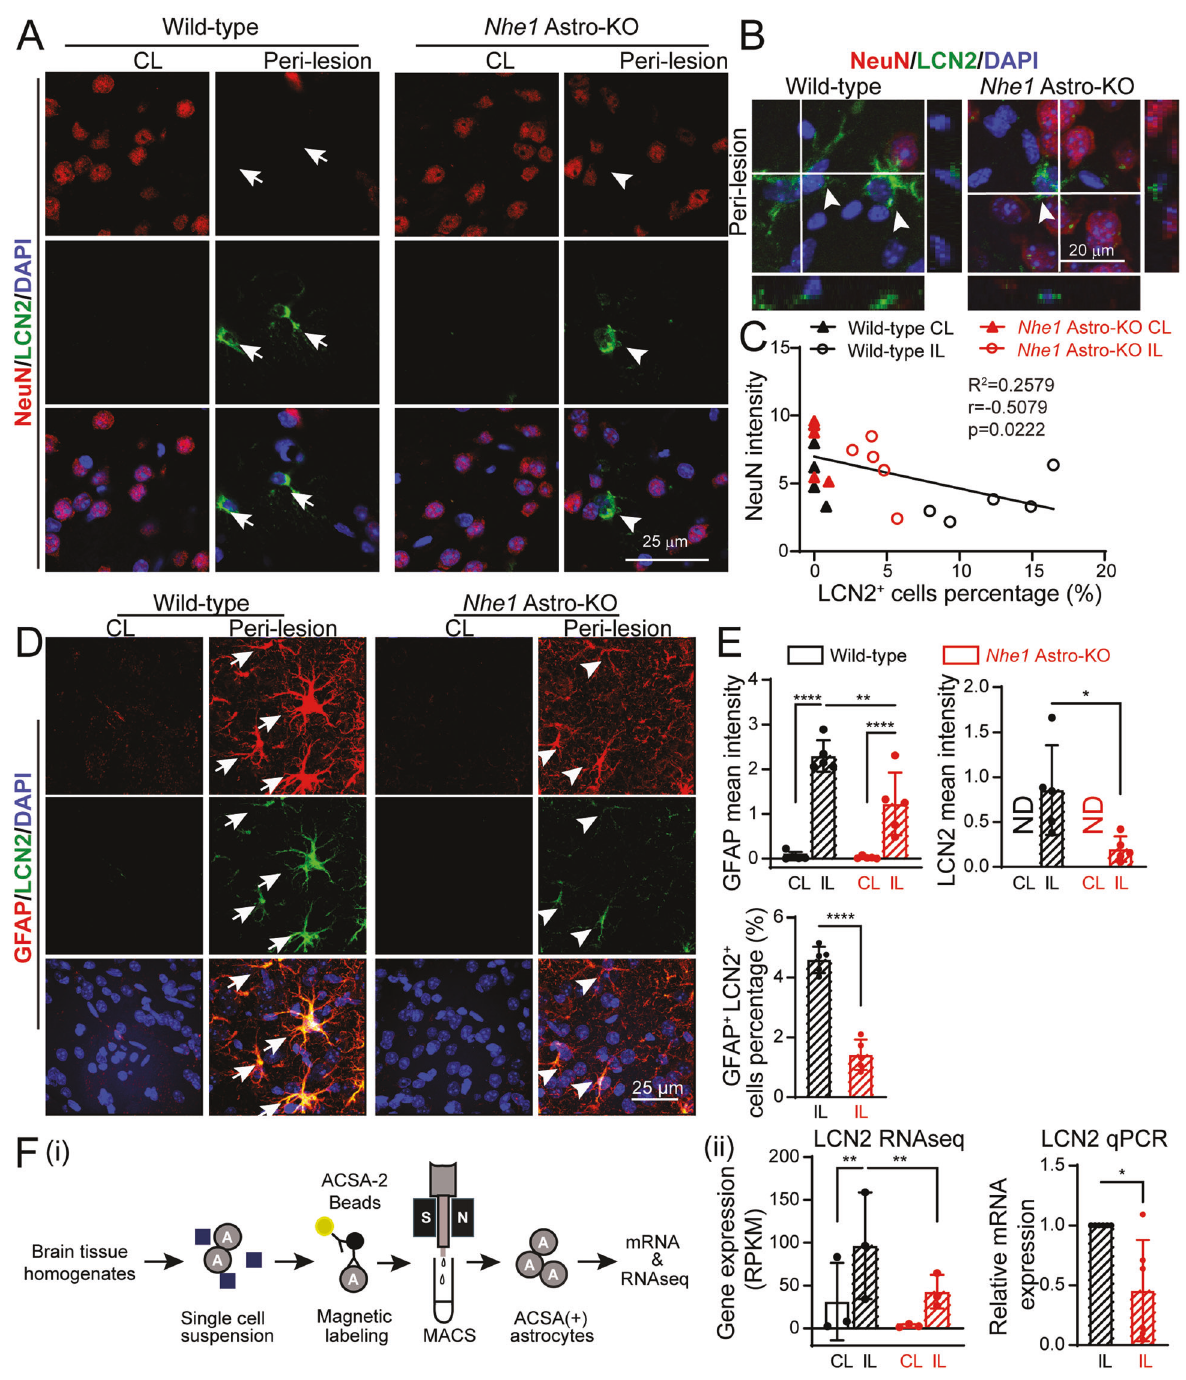
Fig. 2 Stroke-induced LCN2 expression in RA is negatively associated with NeuN + neuronal counts. A Representative confocal images of NeuN and LCN2 expression in astrocytes at 48 h Rp. Arrows : high expression. Arrowheads: low expression. B Orthogonal sections from z stack confocal images showing association of NeuN + neurons with LCN2 + astrocytes (arrows). C Negative correlation between LCN2 expression and NeuN + intensity in wild-type and Nhe1 Astro-KO brains. r = − 0.5079 , p = 0.0222. D Representative confocal images of GFAP and LCN2 expression in astrocytes at 48 h Rp. Arrows : high expression. Arrowheads: low expression. E Summary data shows quanti fi cation of GFAP and LCN2 fl uorescence signal intensity and summary data of GFAP and LCN2 double positive cells percentage. Data are mean ± SD, n = 5. * p < 0.05; ** p < 0.01; *** p < 0.001; **** p < 0.0001 via one-way ANOVA and unpaired t- test. F (i) Cartoon illustrates isolation of astrocyte by MACS. (ii) Relative gene expression of LCN2 expressed as RPKM normalized values and RT-qPCR analysis of changes in expression of LCN2 mRNA in the astrocytes isolated from wild-type and Nhe1 Astro-KO brains at 24 h Rp. Data are mean ± SD n = 6, * p < 0.05 by unpaired t-test.